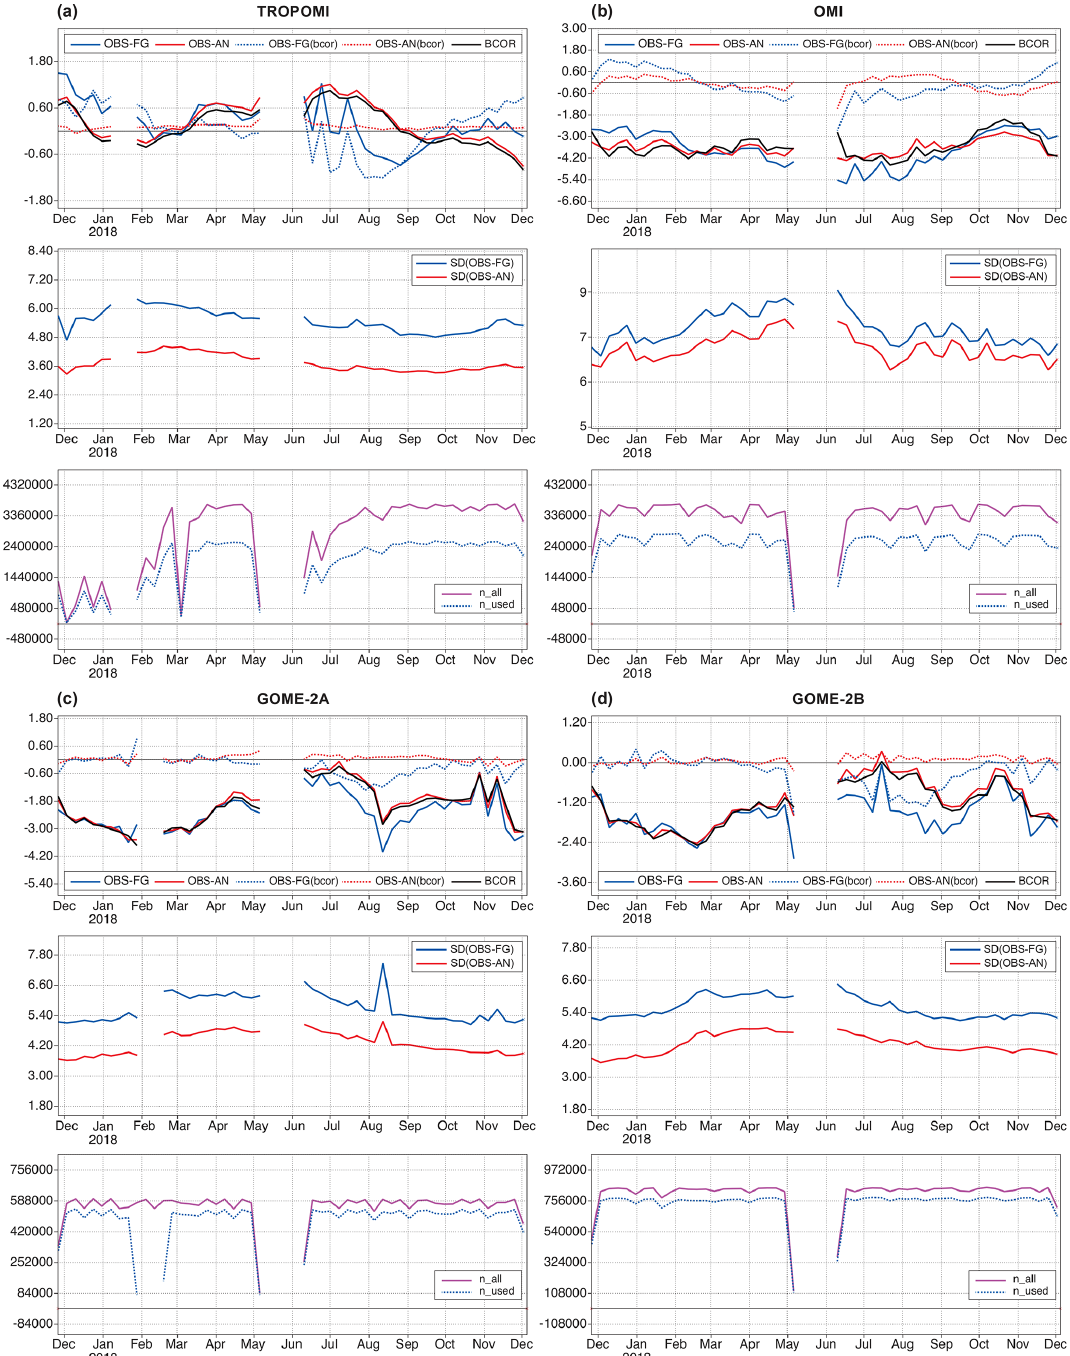
Figure 7. Row 1: Time series for the period 26 November 2017 to 30 November 2018 of global mean weekly averaged TCO3 first-guess (solid blue) and analysis departures (solid red), bias-corrected first-guess (dotted blue) and analysis departures (dotted red) and bias correction (black) in DU. Row 2: standard deviation of first-guess (blue) and analysis departures (red) in DU. Row 3: number of data (used in blue, all in magenta) from (a) TROPOMI, (b) OMI, (c) GOME-2A and (d) GOME-2B. Used data are